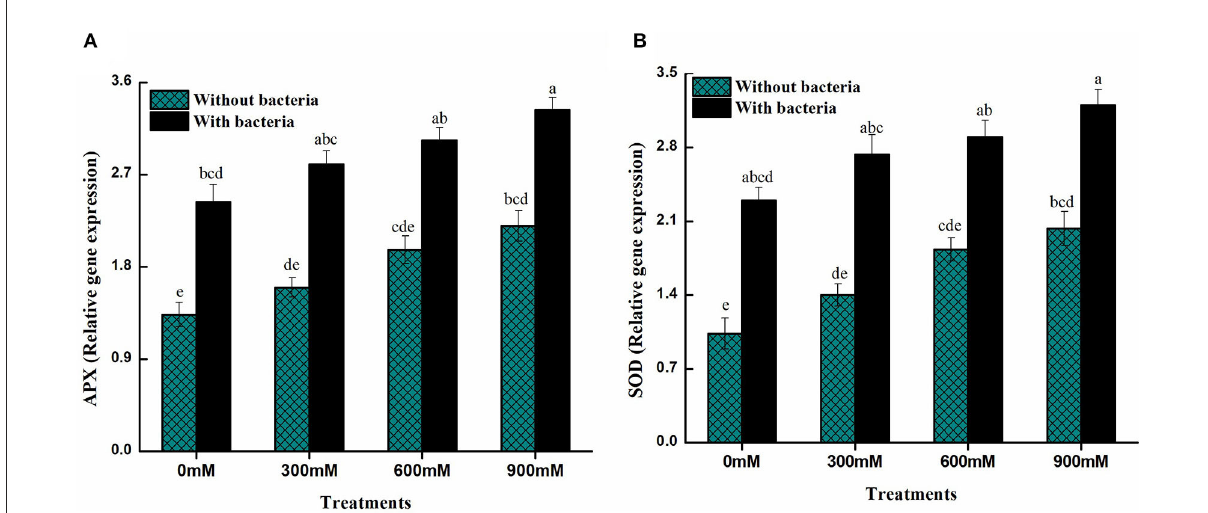
FIGURE6 Expression levels of antioxidant genes of maize in the absence and presence of B. thuringiensis PM25 under salinity stress (A) Ascorbate peroxidase (APX) (B) Superoxide dismutase (SOD). Bars sharing different letter (s) for each parameter are significantly different from each other according to the LSD test ( p ≤ 0.05). All the data represented are the average of three replications ( n = 3). Error bars represent the standard errors (SE) of three